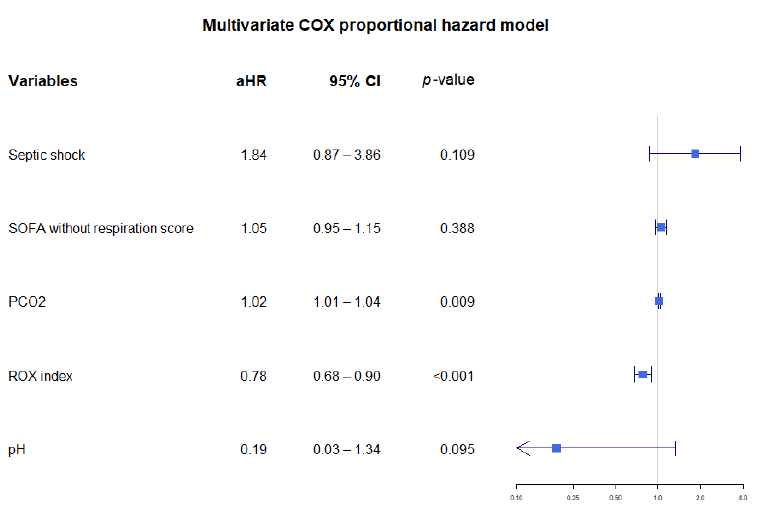
Figure 3. Multivariate cox proportional hazard model using the ROX index. Abbreviations: aHR = adjusted hazard ratio, CI = confidence interval, SOFA = sequential organ failure assessment, PCO 2 = partial pressure of carbon dioxide.